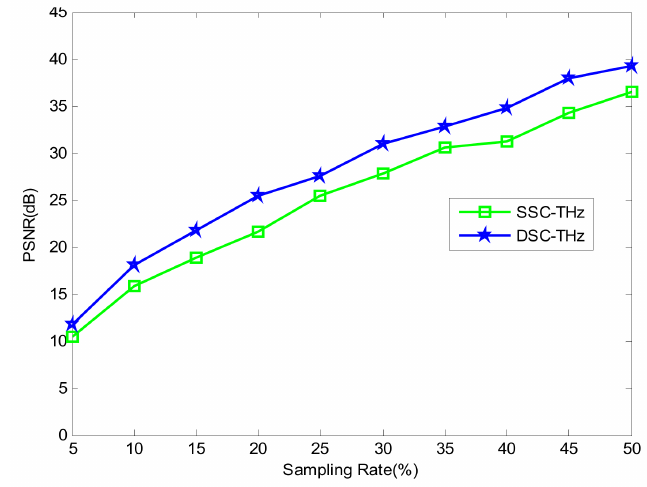
Figure 9. Comparison of the PSNR to different sampling